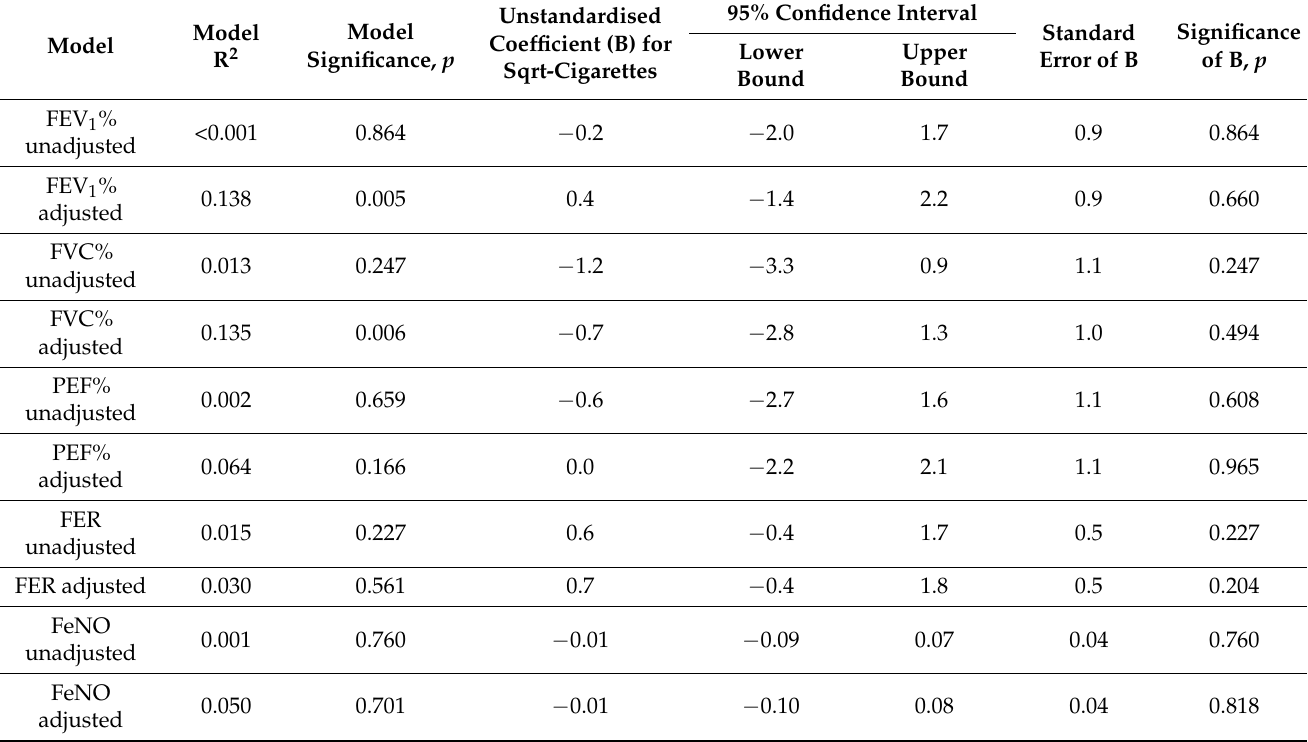
Table 5. Summary of spirometry and FeNO linear regression